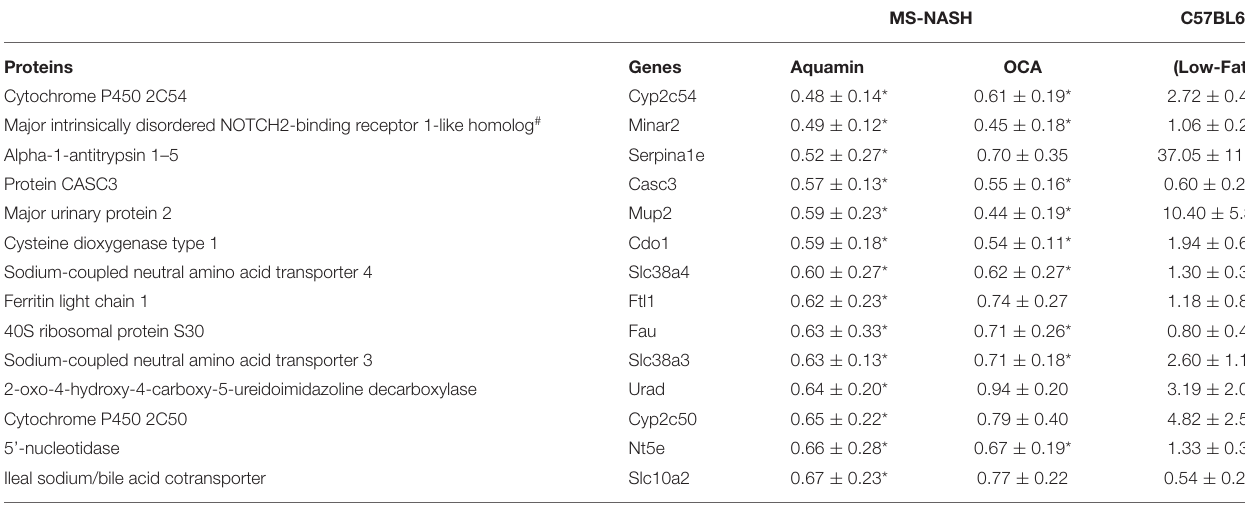
TABLE 1C | Significantly downregulated proteins with Aquamin in high-fat mice.